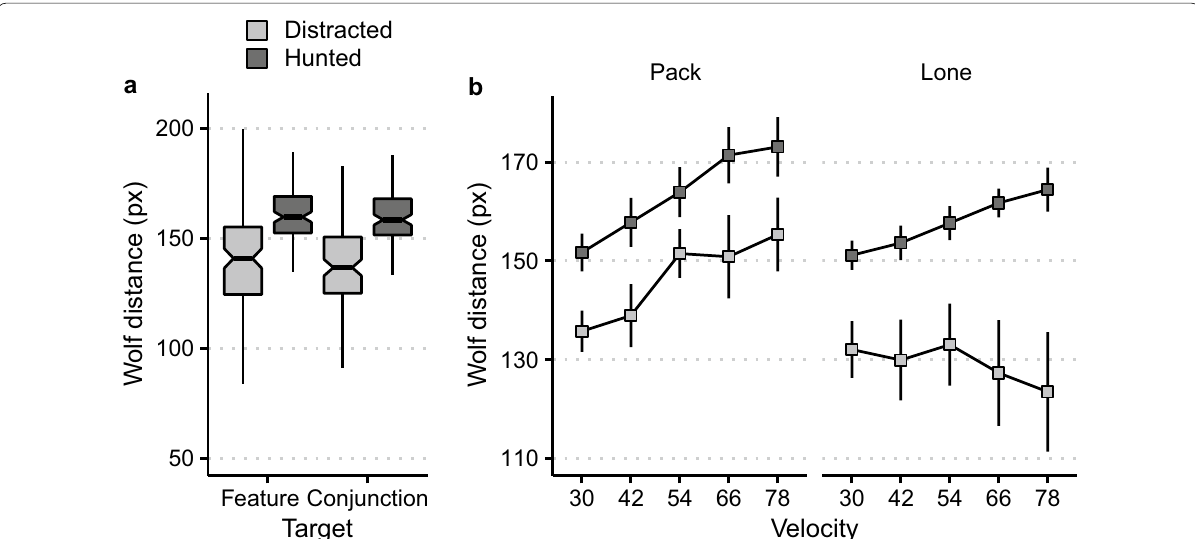
Fig. 3 a The interaction between Predation (Distracted/Hunted) and Target (Feature/Conjunction) for Wolf Distance. Horizontal lines show the central tendency (median) of each distribution, with notches indicating 95% confindence intervals. Boxes identify the upper (75%) and lower (25%) quartiles, with the whiskers indicating maximum and minimum values. b The three-way interaction between Predation (Distracted/Hunted), Wolf Behaviour (Pack/Lone) and Velocity. Error bars indicate 95% confidence intervals